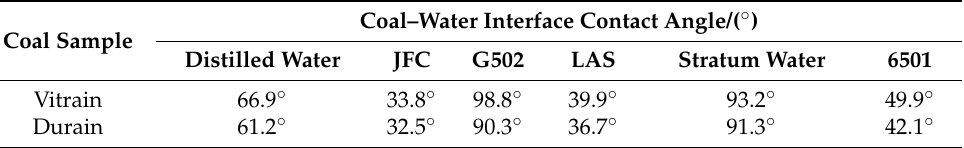
Table 5. Measurement results of the contact angle of the coal–water interface. Coal